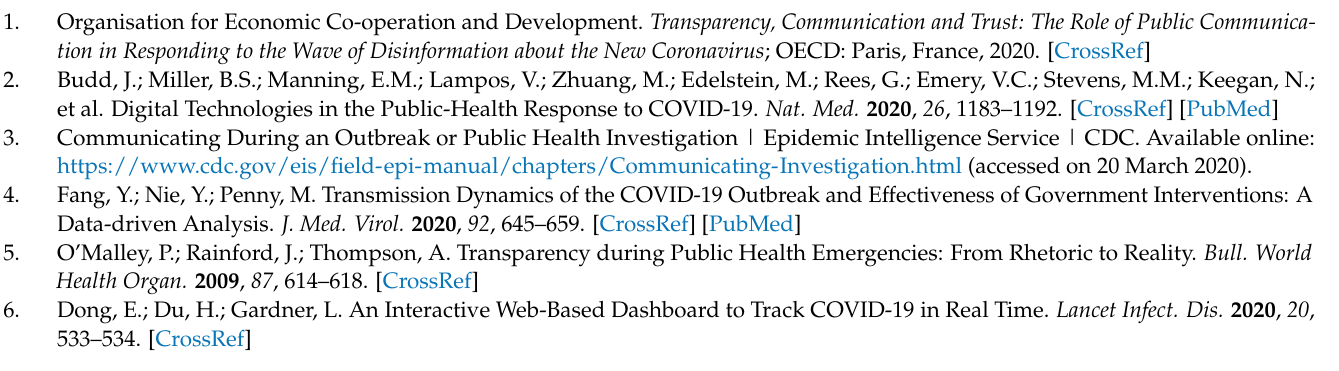
data. Figure S2: WEB app structure concerning relations with R code, data, environment and storing